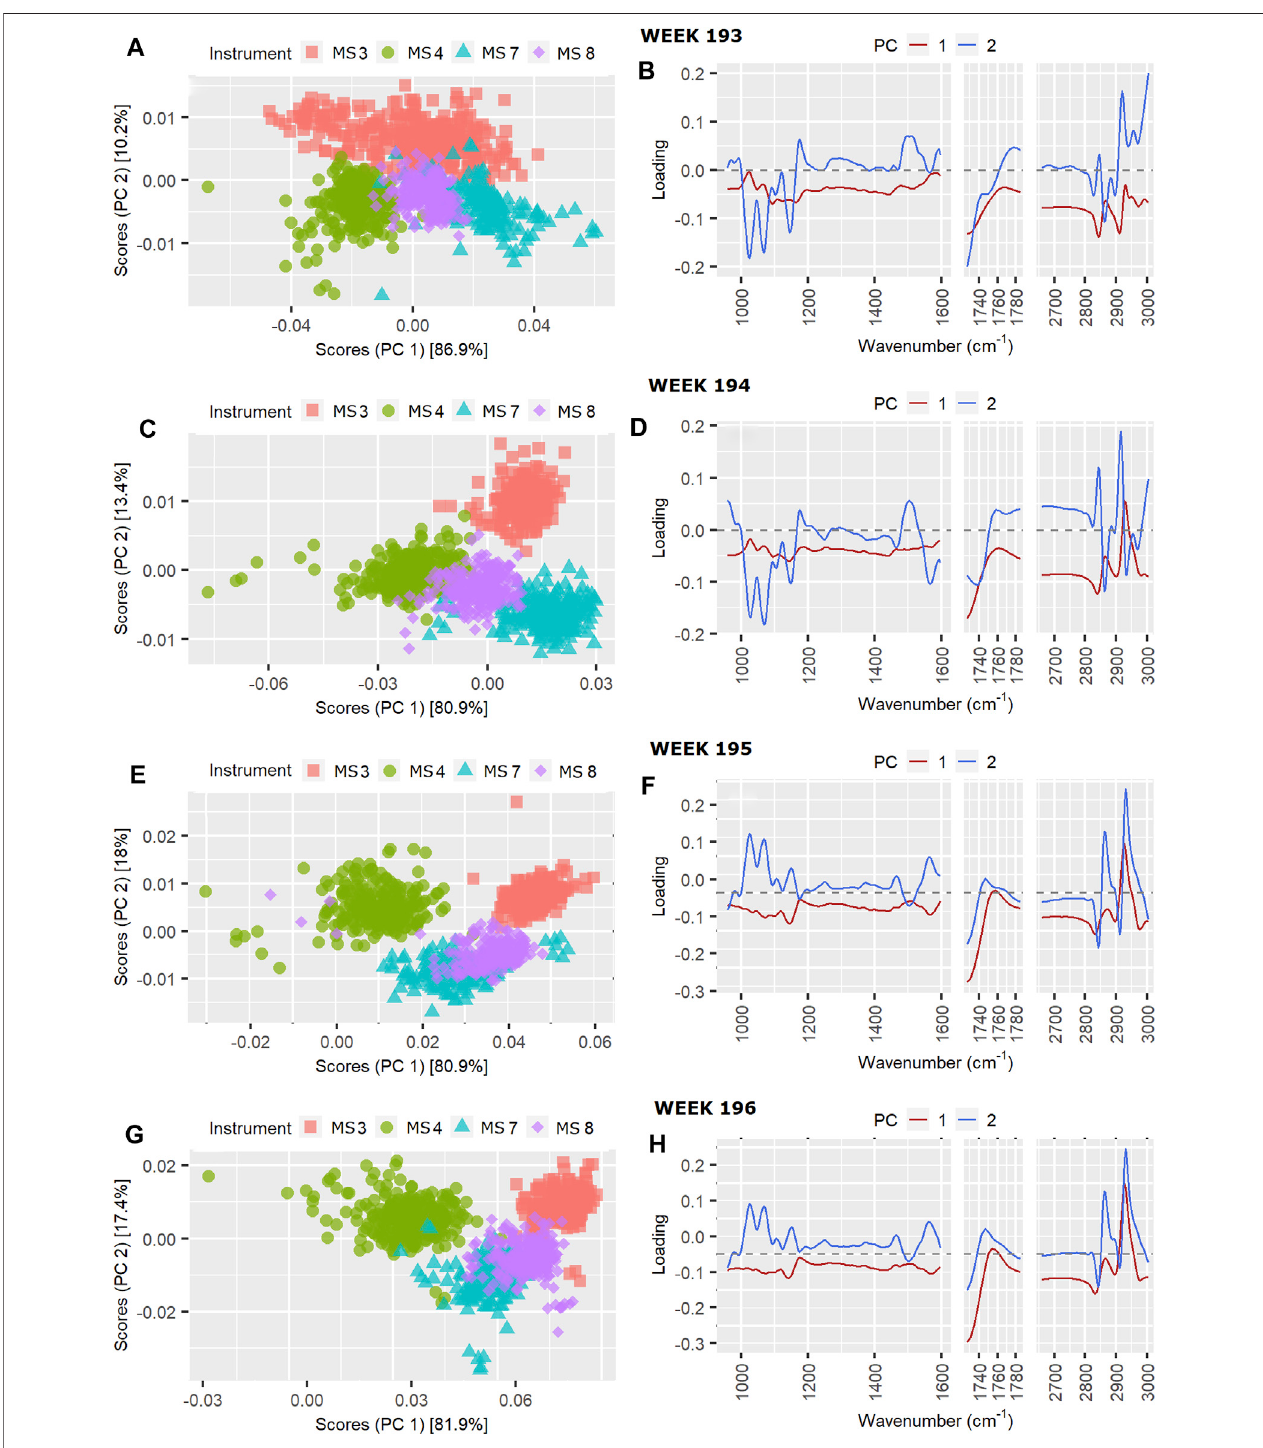
FIGURE 6 | Instrument scores and loading plots, respectively, for pilot spectra from four successive weeks: (A) and (B) week 193, (C) and (D) week 194, (E) and (F) week 195 and (G) and (H) week 196.